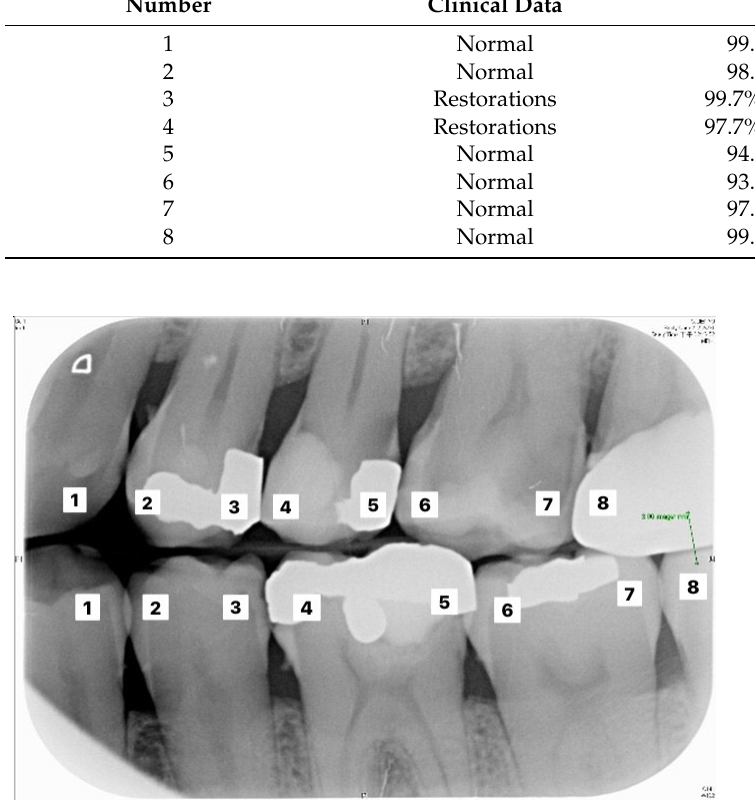
Figure 10. Image example of outer teeth for validation (from left to right, in order of 1–8). Table 8. Truth table of accuracy for classifying caries.